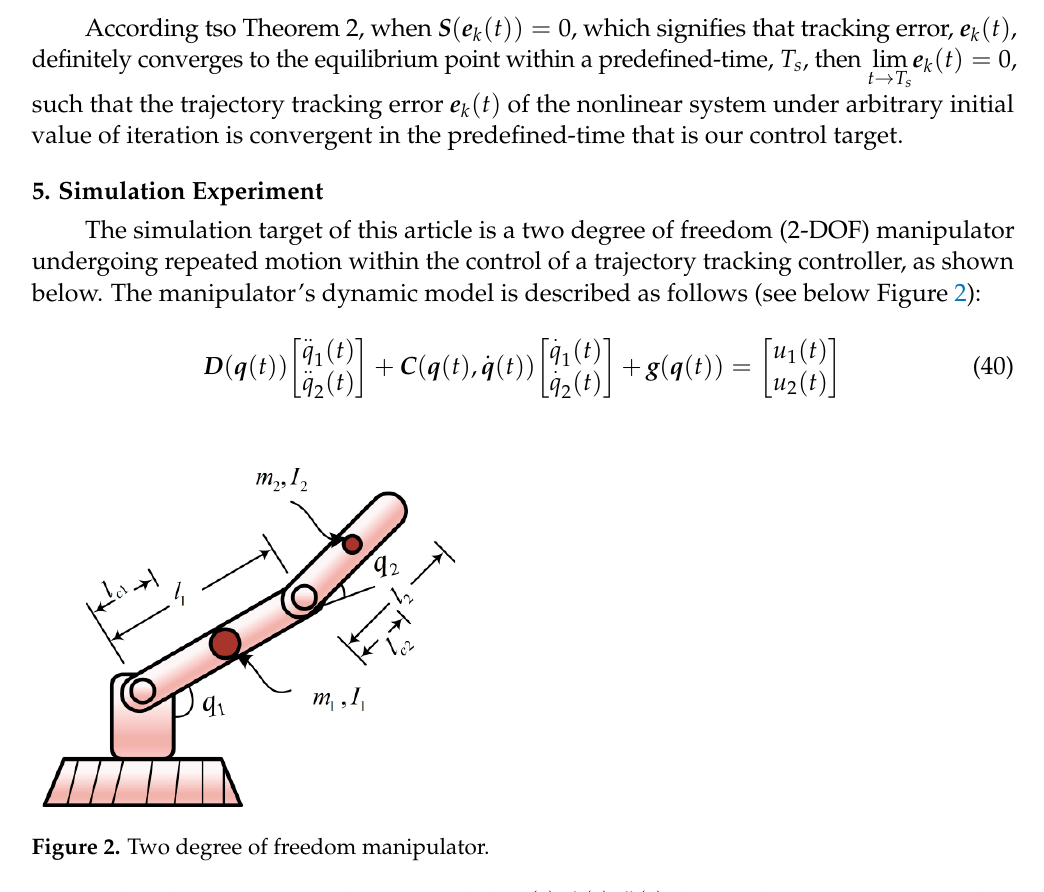
Table 1. Parameters of robotic